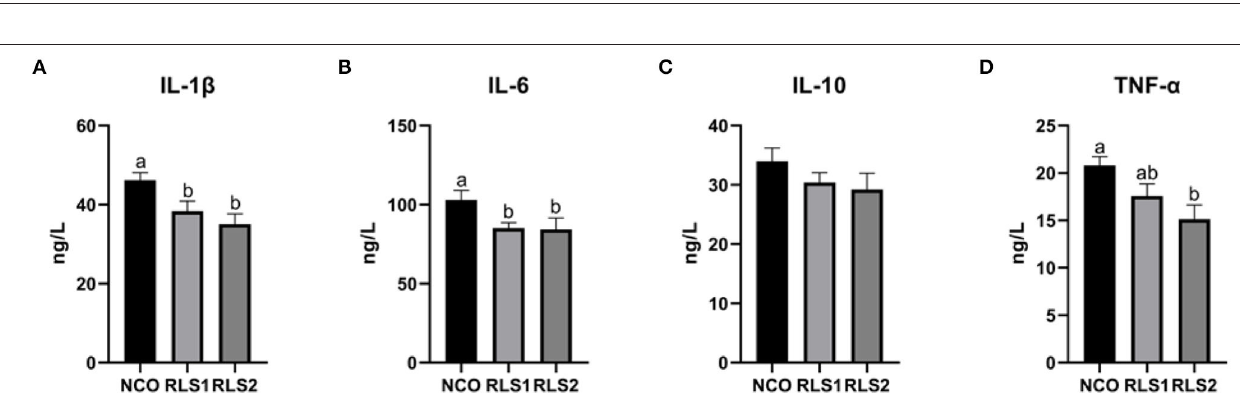
FIGURE 3 | Effects of RLS on the expression of lipid synthesis and degradation-related genes in the liver of rats. NCO, rats were gavage-fed normal saline; RLS1, rats were gavage-fed 10mg RLS / 200g body weight; RLS2, rats were gavage-fed 20mg RLS / 200g body weight. ACC, acetyl-CoA carboxylase; FAS, fatty acid synthase; Srebp-1c, sterol regulatory-element binding proteins-1c; CPT-1, carnitine palmitoyltransferase-1; CPT-2, carnitine palmitoyltransferase-2; PGC-1 α , peroxisome proliferator-activated receptor-gamma coactivator-1 α . Values are expressed as the mean ± SEM, n = 8. Different letters represent a significant difference of P < 0.05. Part labels represent standard error for the sample mean (SEM).